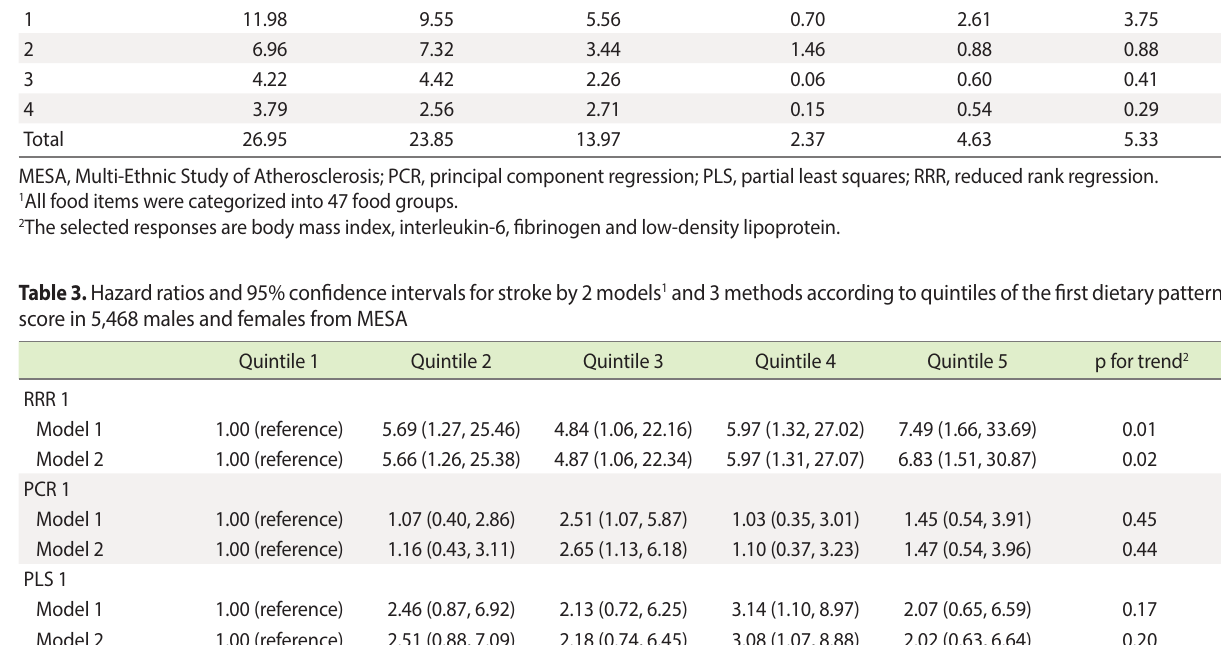
Table 2. Explained variation in food groups and responses by 3 methods from MESA data Factor